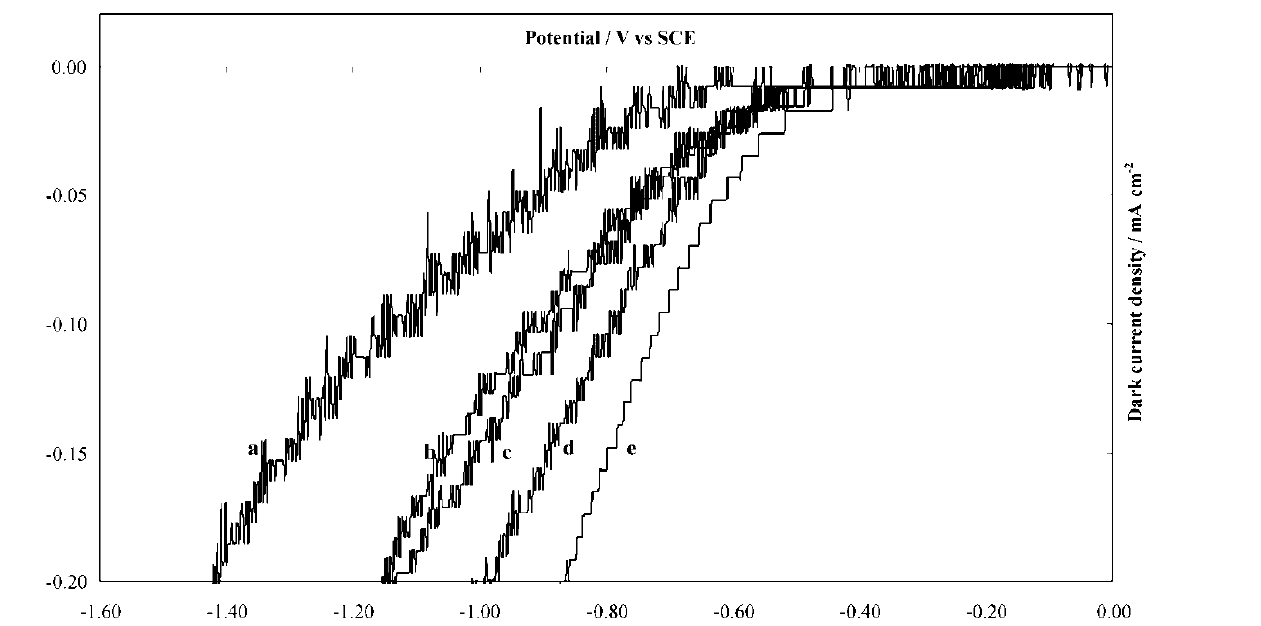
FIGURE 1 Dark J – V plots for (a) unheated n -Si. Quenched n -Si samples from (b) 400 (cid:1) C, (c) 500 (cid:1) C, (d) 600 (cid:1) C, and (e) 700 (cid:1) C. All J – V measurements were conducted in water = LiClO 4 = K 4 [Fe(CN) 6 ] = K 3 [Fe(CN) 6 ] at 25 (cid:1)